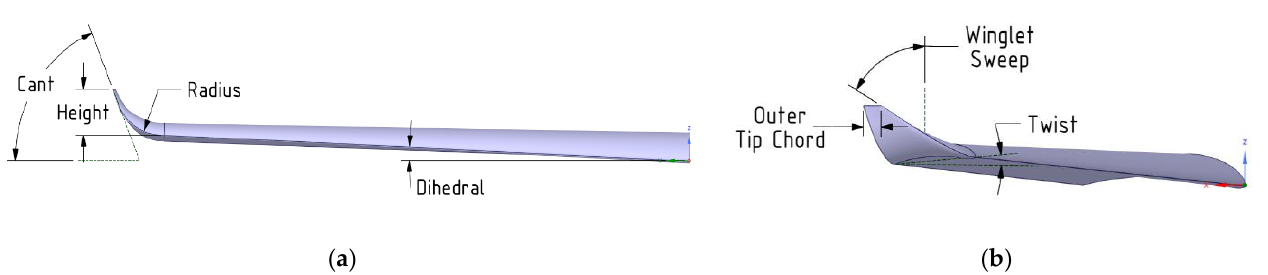
Figure 1. ( a ) Front view of the designed wing with the winglet; ( b ) perspective view of the designed wing with the winglet.